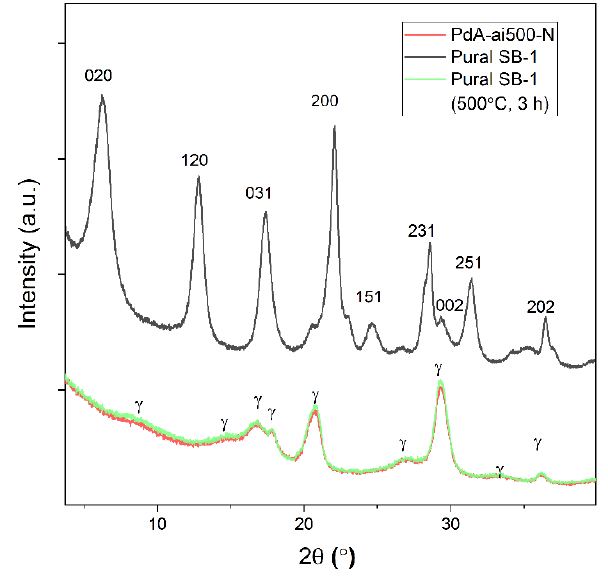
Figure 1. XRD diffractograms of initial Pural SB-1, Pural SB-1 calcinated at 550 ◦ C and PdA-AI- Figure 1 . XRD diffractograms of initial Pural SB-1, Pural SB-1 calcinated at 550 °C and PdA-AI- 500-N catalyst. 500-N catalyst.